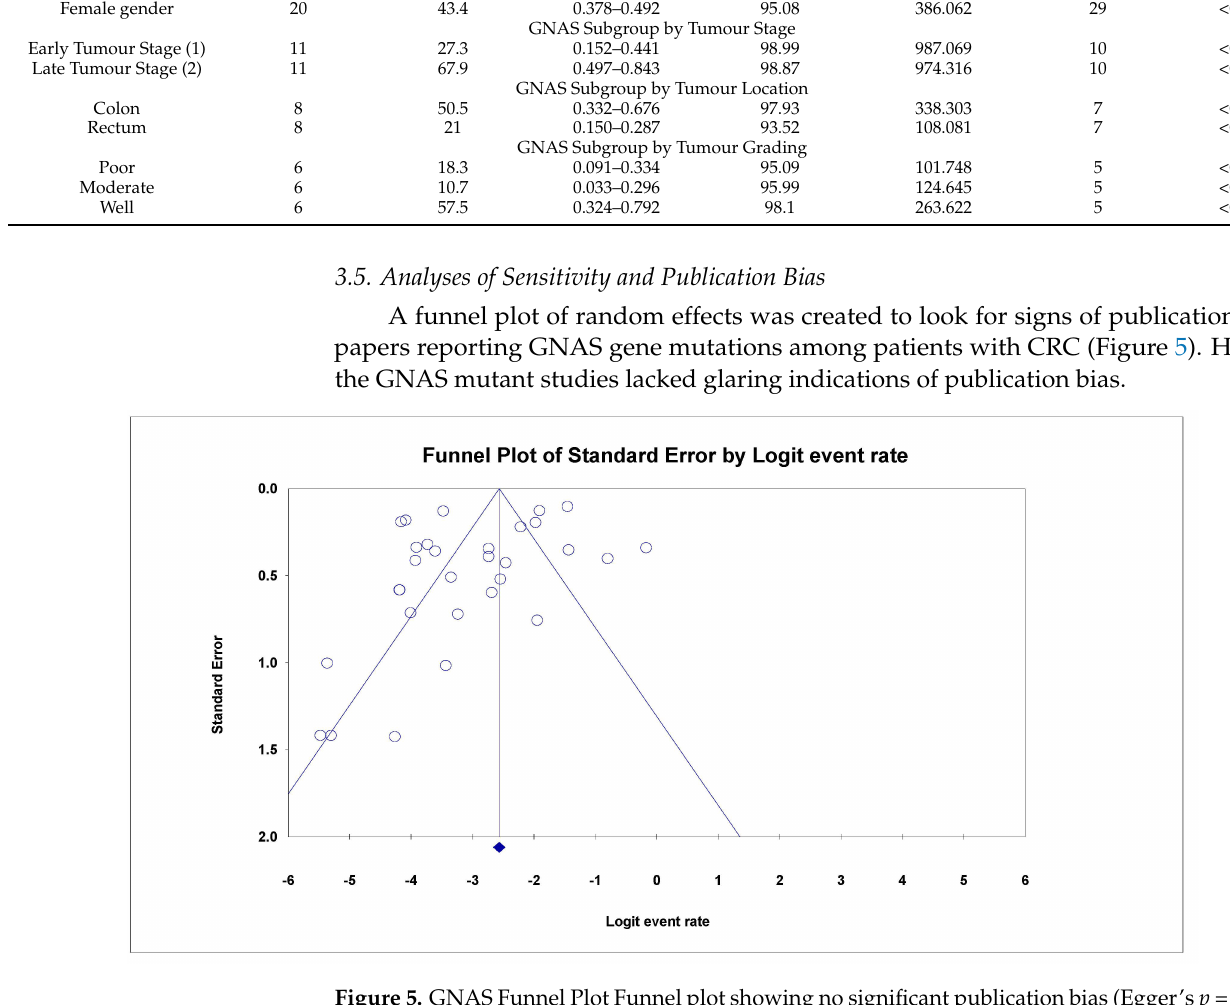
Figure 5. GNAS Funnel Plot Funnel plot showing no significant publication bias (Egger’s p =